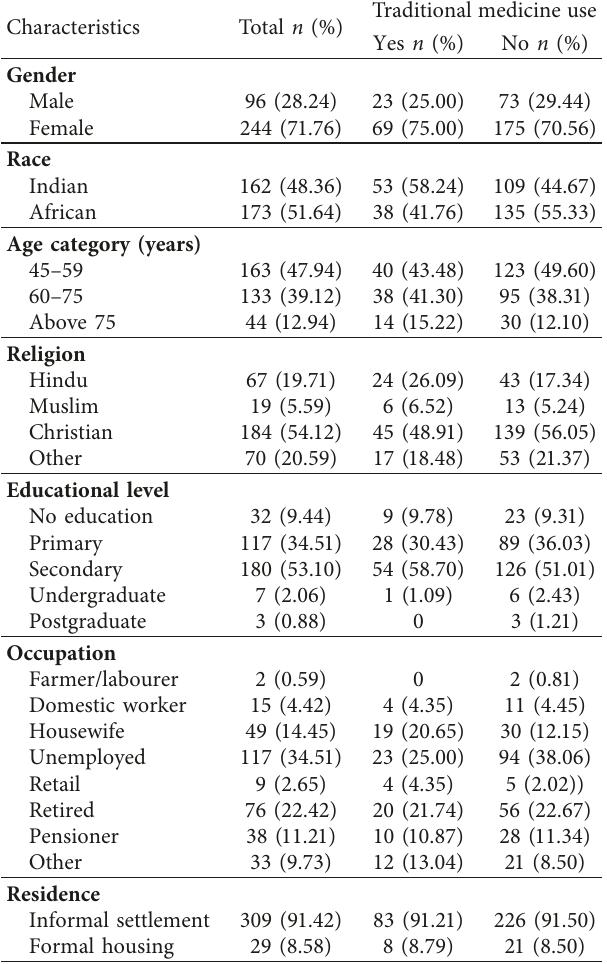
Table 1: Demographic profile of type 2 diabetes mellitus patients stratified by traditional medicine use ( N � 340).